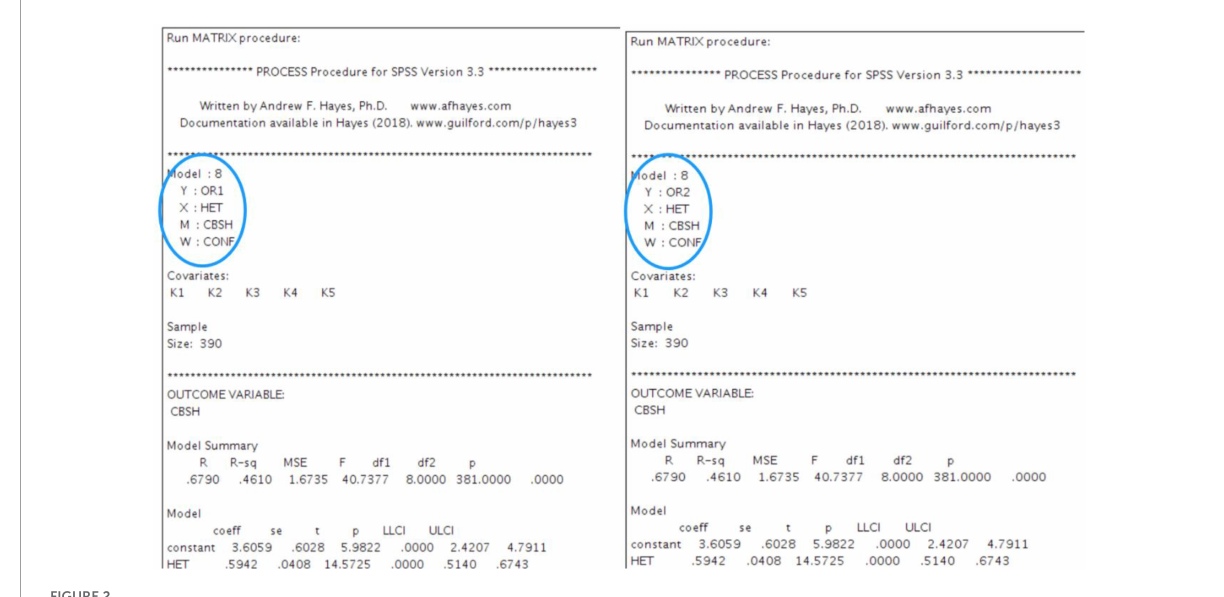
FIGURE2 Screenshot of the running interface of the software used in this